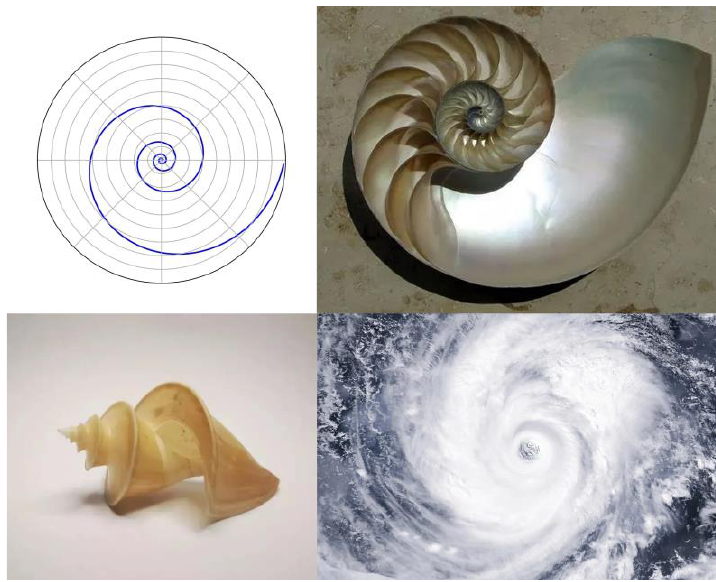
Figure 1. The Archimedes spiral shape in nature.